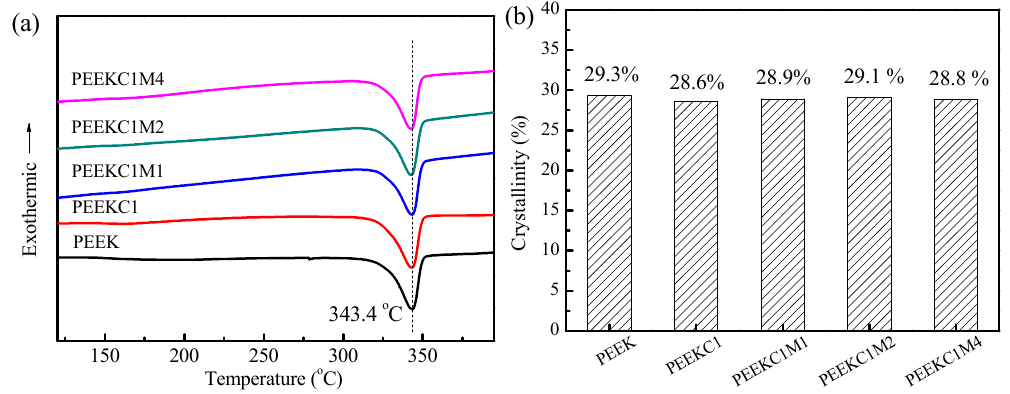
Figure 8. ( a ) DSC traces of PEEK nanocomposites recorded during heating at a rate of 10 °C/min for the injection molded samples, and ( b ) the resultant crystallinity.